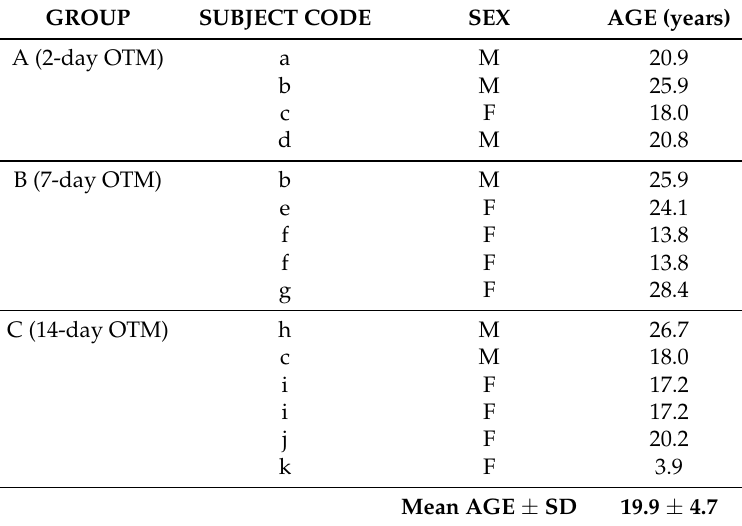
Table 1. Demographics of subjects included for PDL collection.